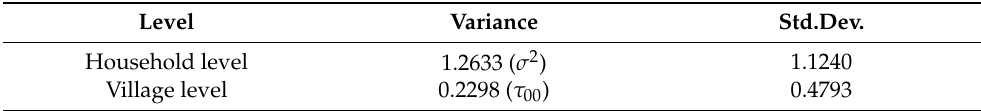
Table 4. The random effects of the null